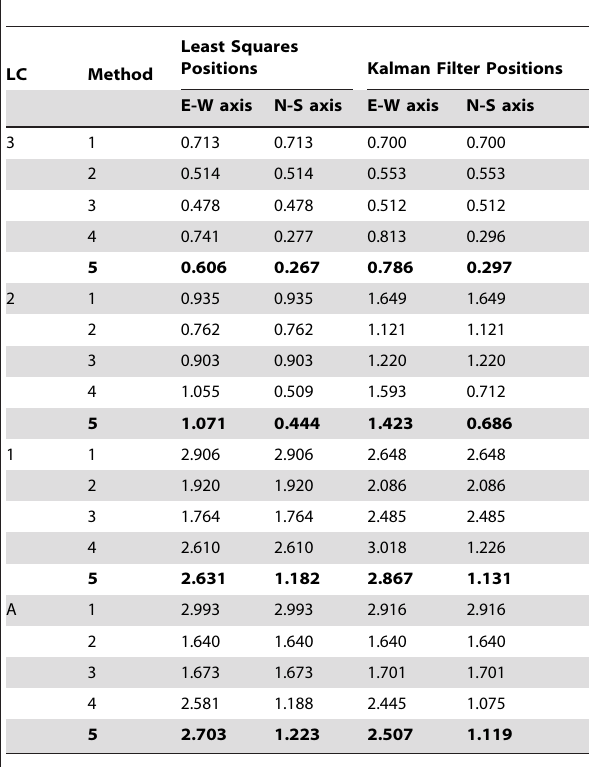
Table 8. Empirical estimates of the 68% accuracy ellipses/ circles for LCs 3, 2, 1, and